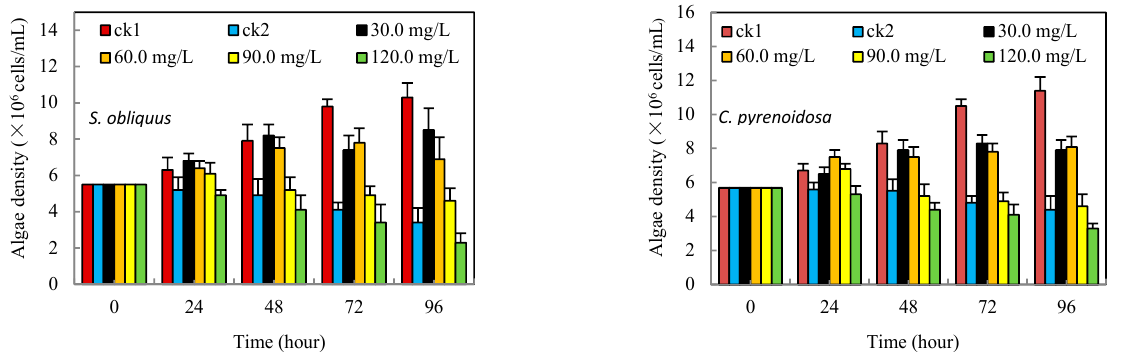
Figure 1. Effects of salicylic acid on the biomass of S. obliquus and C. pyrenoidosa under Cd 2+ stress. Table 1. Salicylic acid (mg/L) on the inhibitory rates (%) of S. obliquus and C. pyrenoidosa under Cd 2+ stress.